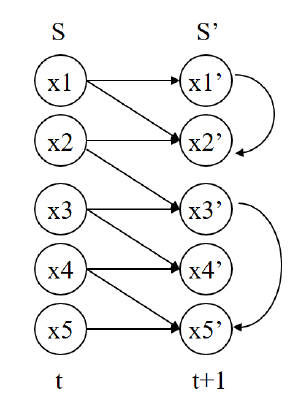
Figure 1. A basic Dynamic Bayesian Network with 5 domain variables and diachronic and synchronic